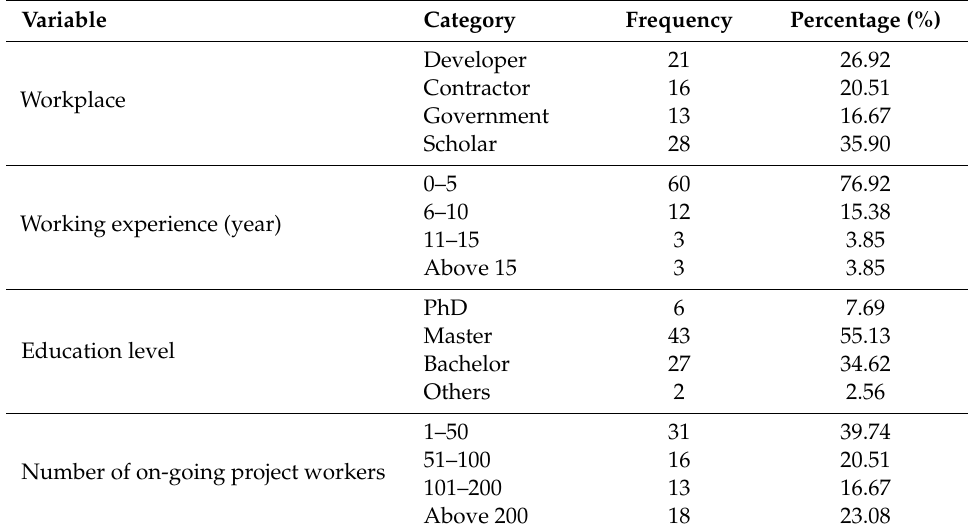
Table 2. Personal background information of the